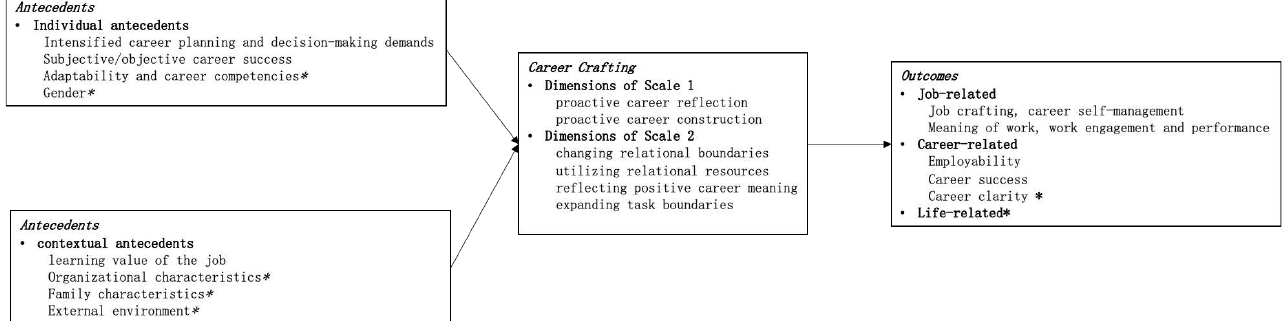
Figure 1. Diagram of the theoretical framework of career crafting (summary of this study, * represents empirical tests in the